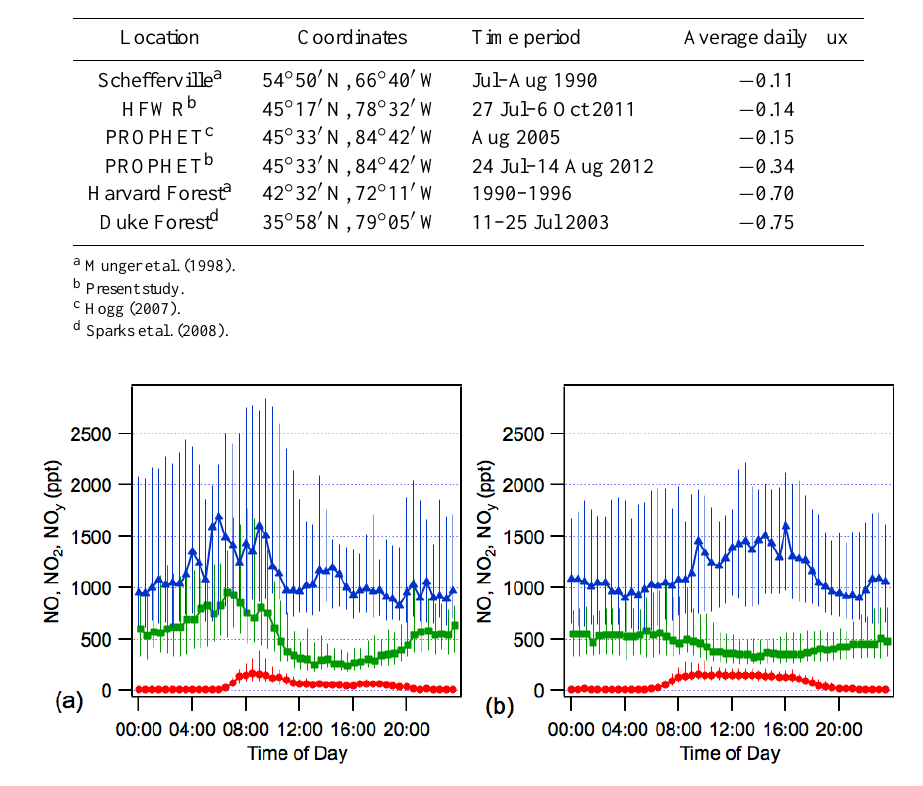
Table 1. Average daily summertime NO y fluxes (mg ( N ) m − 2 day − 1 ) above several North American forests measured directly by eddy covariance.